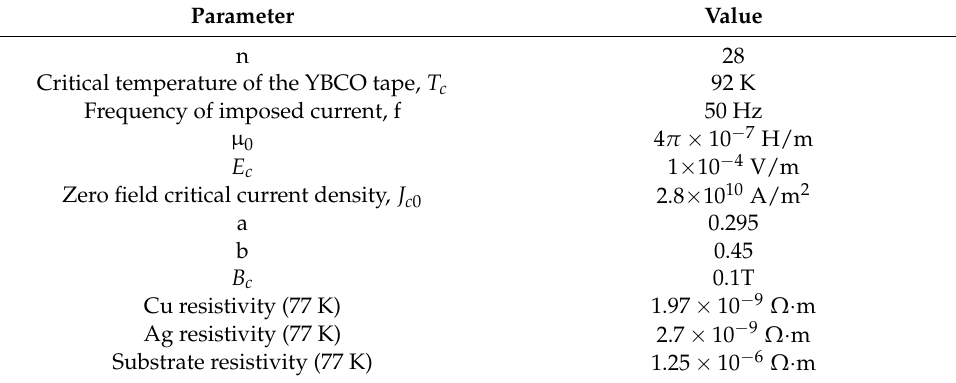
Table 1. The main parameters of electromagnetic field and loss calculation.